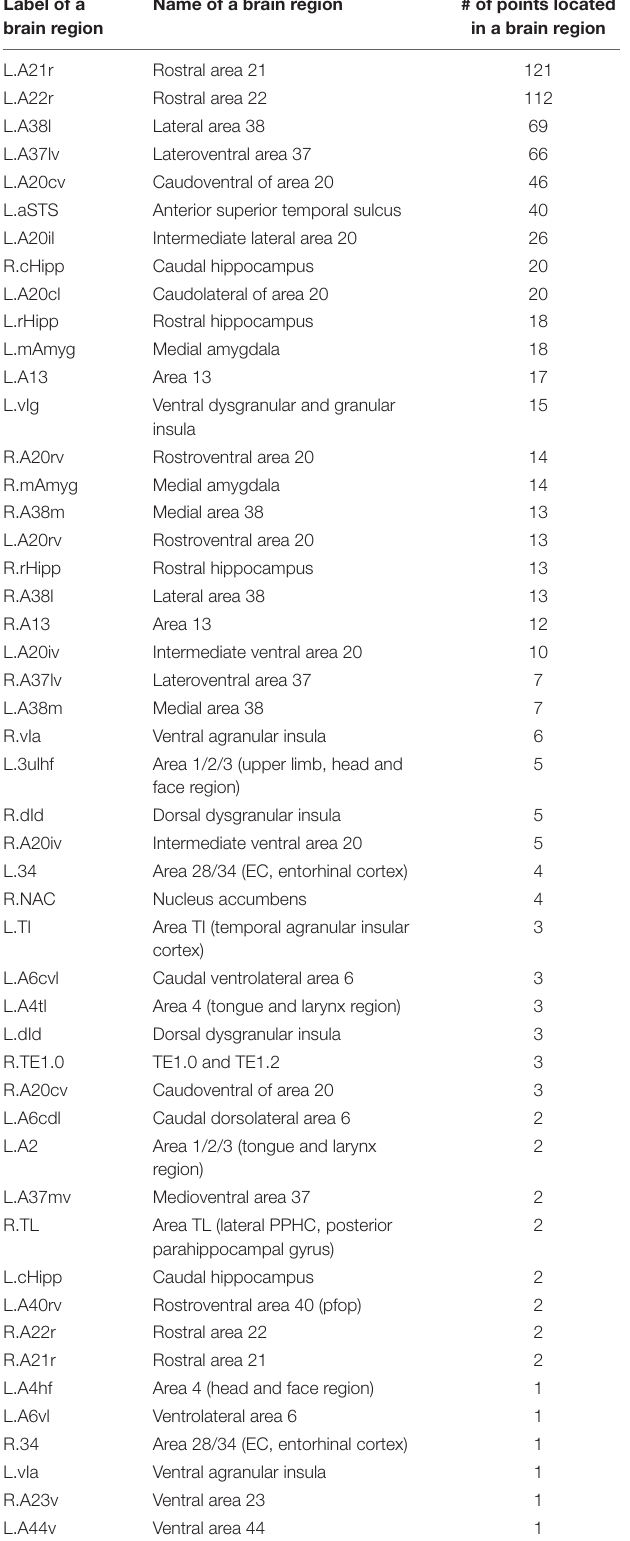
TABLE 8c | Discriminable brain regions in the MCIc vs. MCInc classification task. Label of a brain region